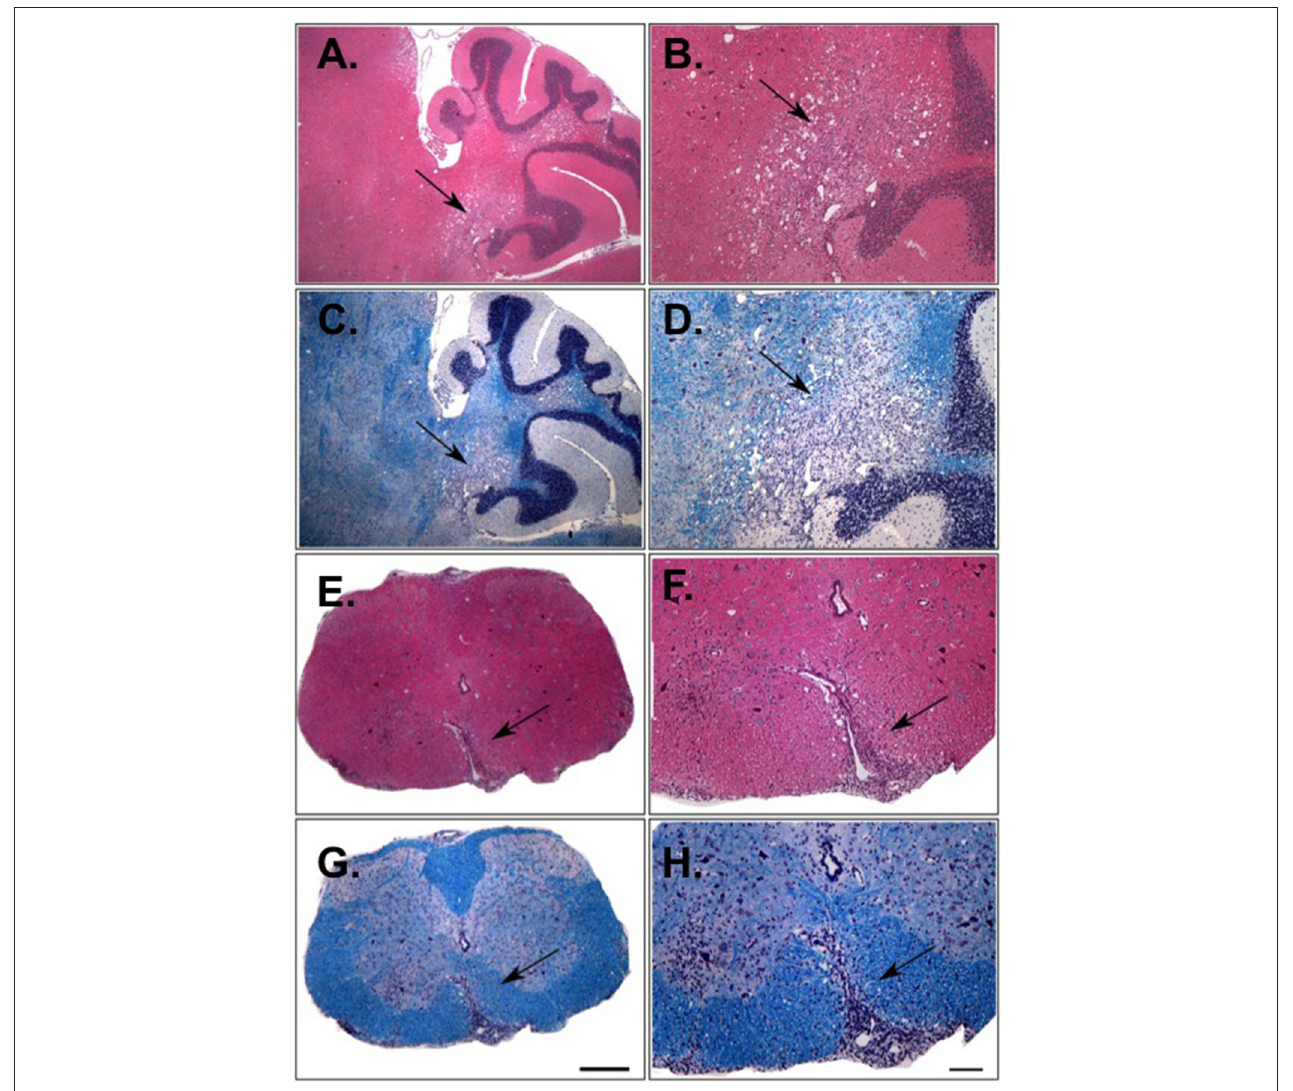
FIGURE 3 | Histological analysis of the CNS of 1C6 × Rag1 − / − mice that develop spontaneous EAE. Cerebellar (A–D) and spinal cord (E–H) lesions from an 18-weeks old male 1C6 × Rag1 − / − mouse that spontaneously developed paralytic disease. H&E staining ( A,B,E,F ) was used to identify inflammatory foci, and Luxol fast blue was used to detect myelin (C,D,G,H) . Arrows indicate inflammatory damage. (A,C,E,G) , 10 × magnification. (B,D,F,H) , 4 × magnification. Scale bars, 100 µ m. Representative of eight animals (6 female, 2